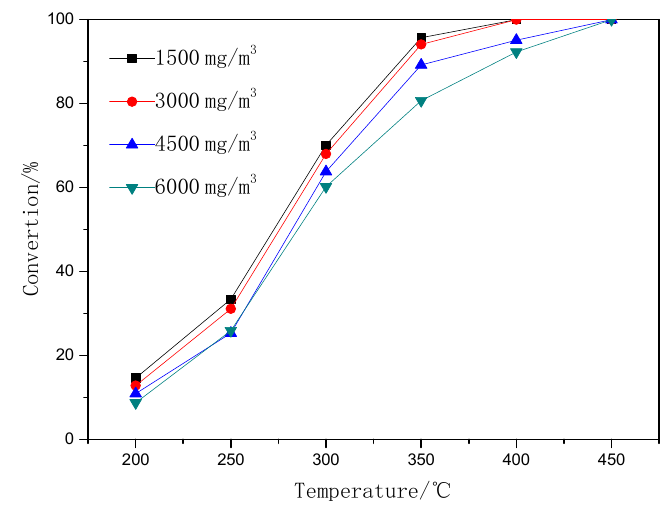
Figure 9. Catalytic oxidation of CB at di ff erent CB concentrations.